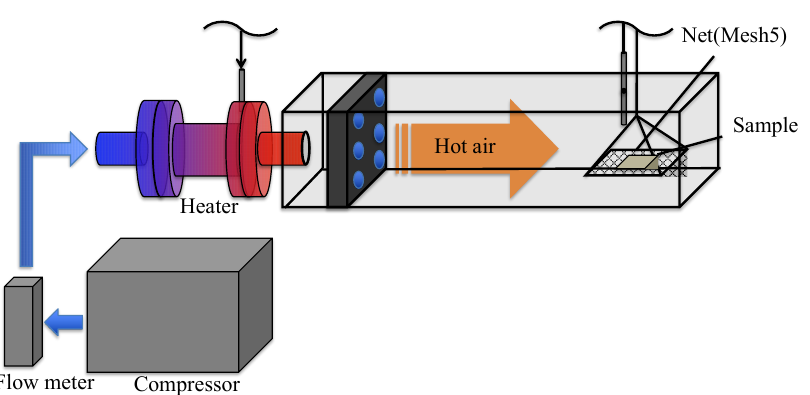
Figure 3. Outline of hot-air drying experimental setup (one side drying of sample).